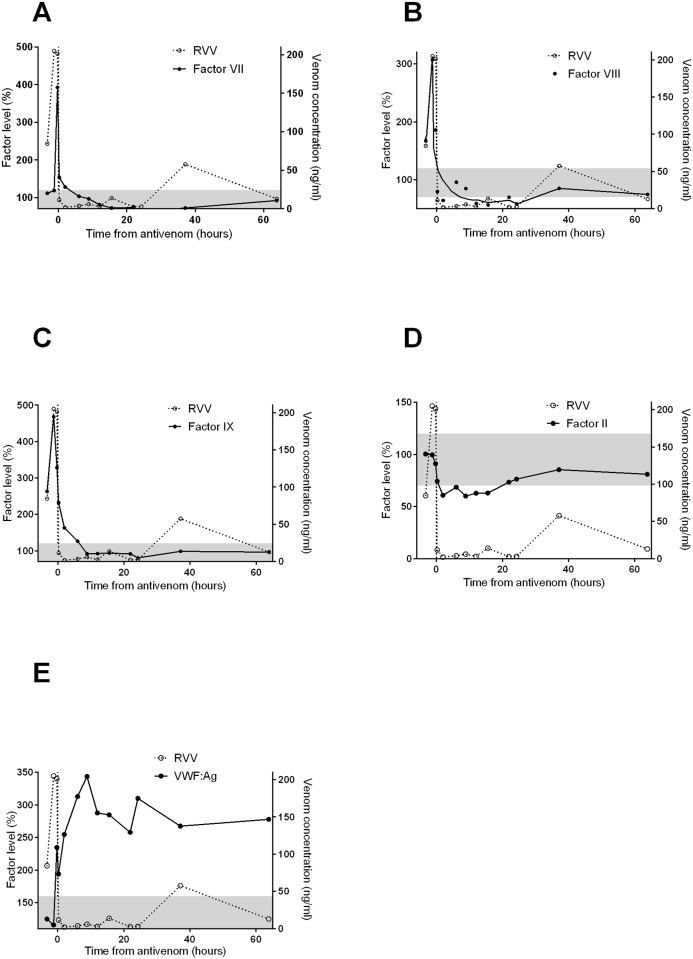
Plots of median venom concentrations (open circles [○] and dashed lines; all panels), clotting times and factor concentrations (filled circles [●] and lines) versus time post-antivenom for 146 patients with Russell’s viper envenoming including factor VII (A; thick lines), factor VIII (B), factor IX (C), factor II (D) and v-WF antigen (E).The black lines represent the interpolated median factor concentration time curves and the shaded area is the normal range for each test. RVV—Russell’s viper venom; VWF:Ag—von Willebrand factor antigen.